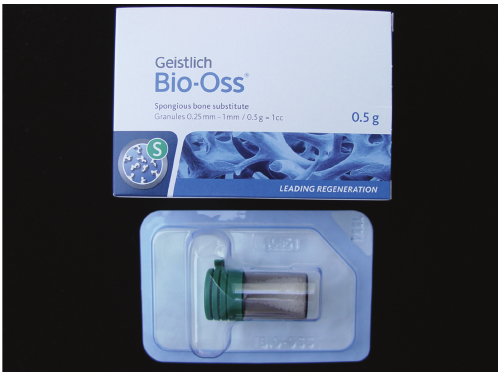
Figure 1: Xenograft (bovine origin) with small granules used in the study.